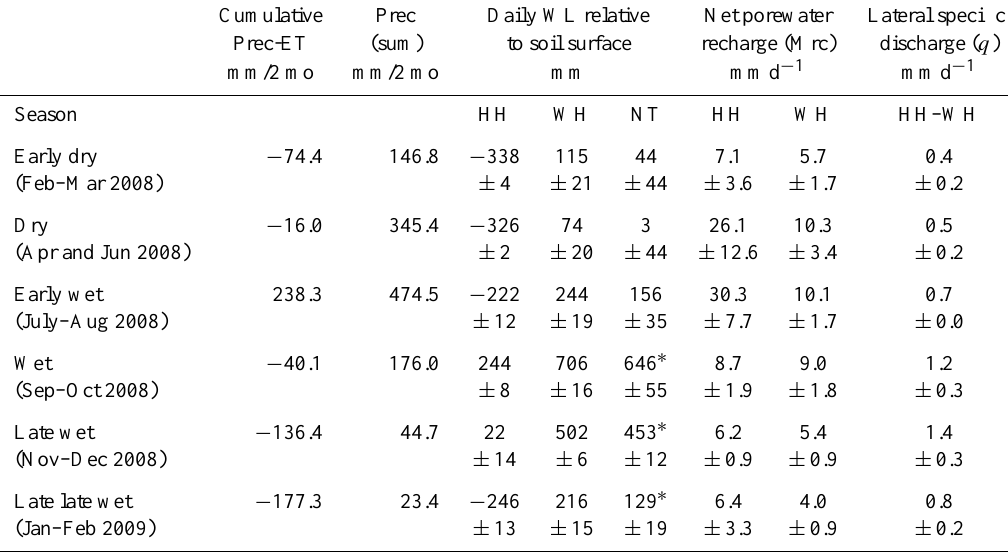
Table 1. Intra-annual variability in hydrologic variables summed or averaged over a two-month period characterizing different regional and local hydrologic conditions. Parameters include a measure of the climatological precipitation deficit [cumulative (Prec) precipitation minus evapotranspiration (ET)], sum of precipitation (Prec), water level (WL) relative to the soil surface ( n = 3) of High Head (HH), Wet Head (WH) and Near Tail (NT), net porewater inflow (Mrc) for the High Head (HH) and Wet Head (WH) and specific discharge ( q ). Standard error values are indicated below mean values. See text for further details of calculations. Cumulative Prec Daily WL relative Net porewater Lateral specific Prec-ET (sum) to soil surface recharge